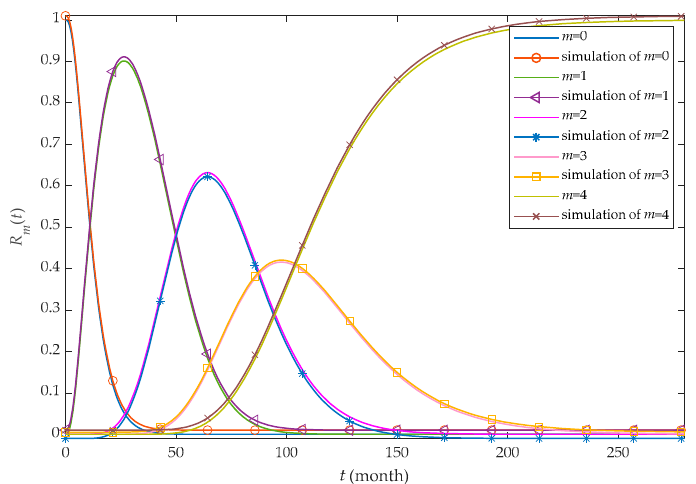
Figure 7. Analytic and simulative results of state probability function of an entire system.